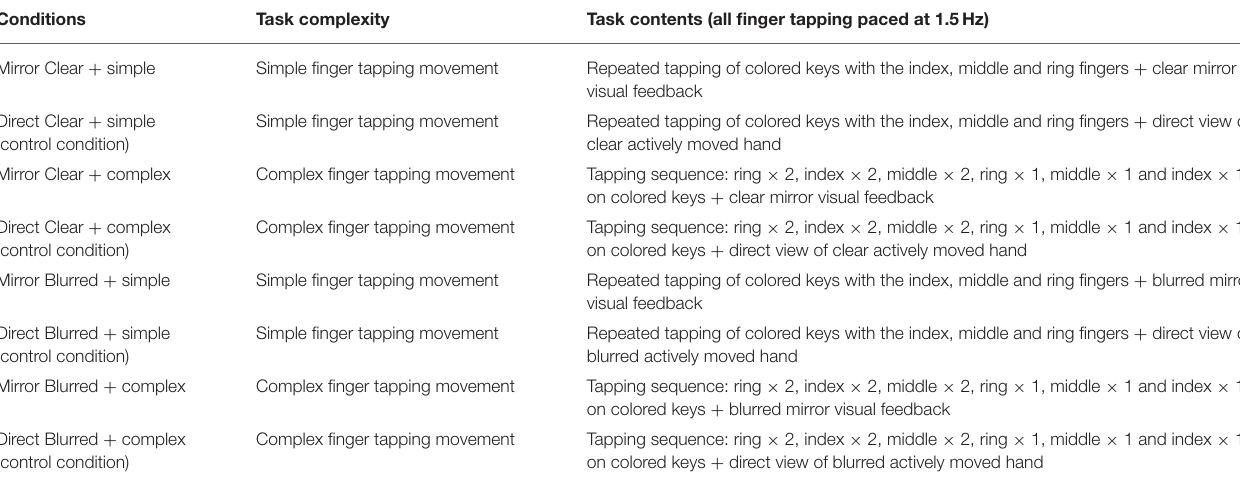
TABLE 1 | Descriptions of different finger tapping conditions in terms of task complexity and contents.